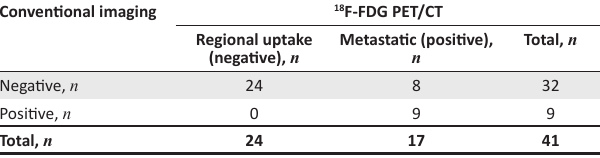
TABLE 2: The 18 F-Fluorodeoxyglucose positron emission tomography/computed tomography versus conventional imaging cross-tabulation. Conventional